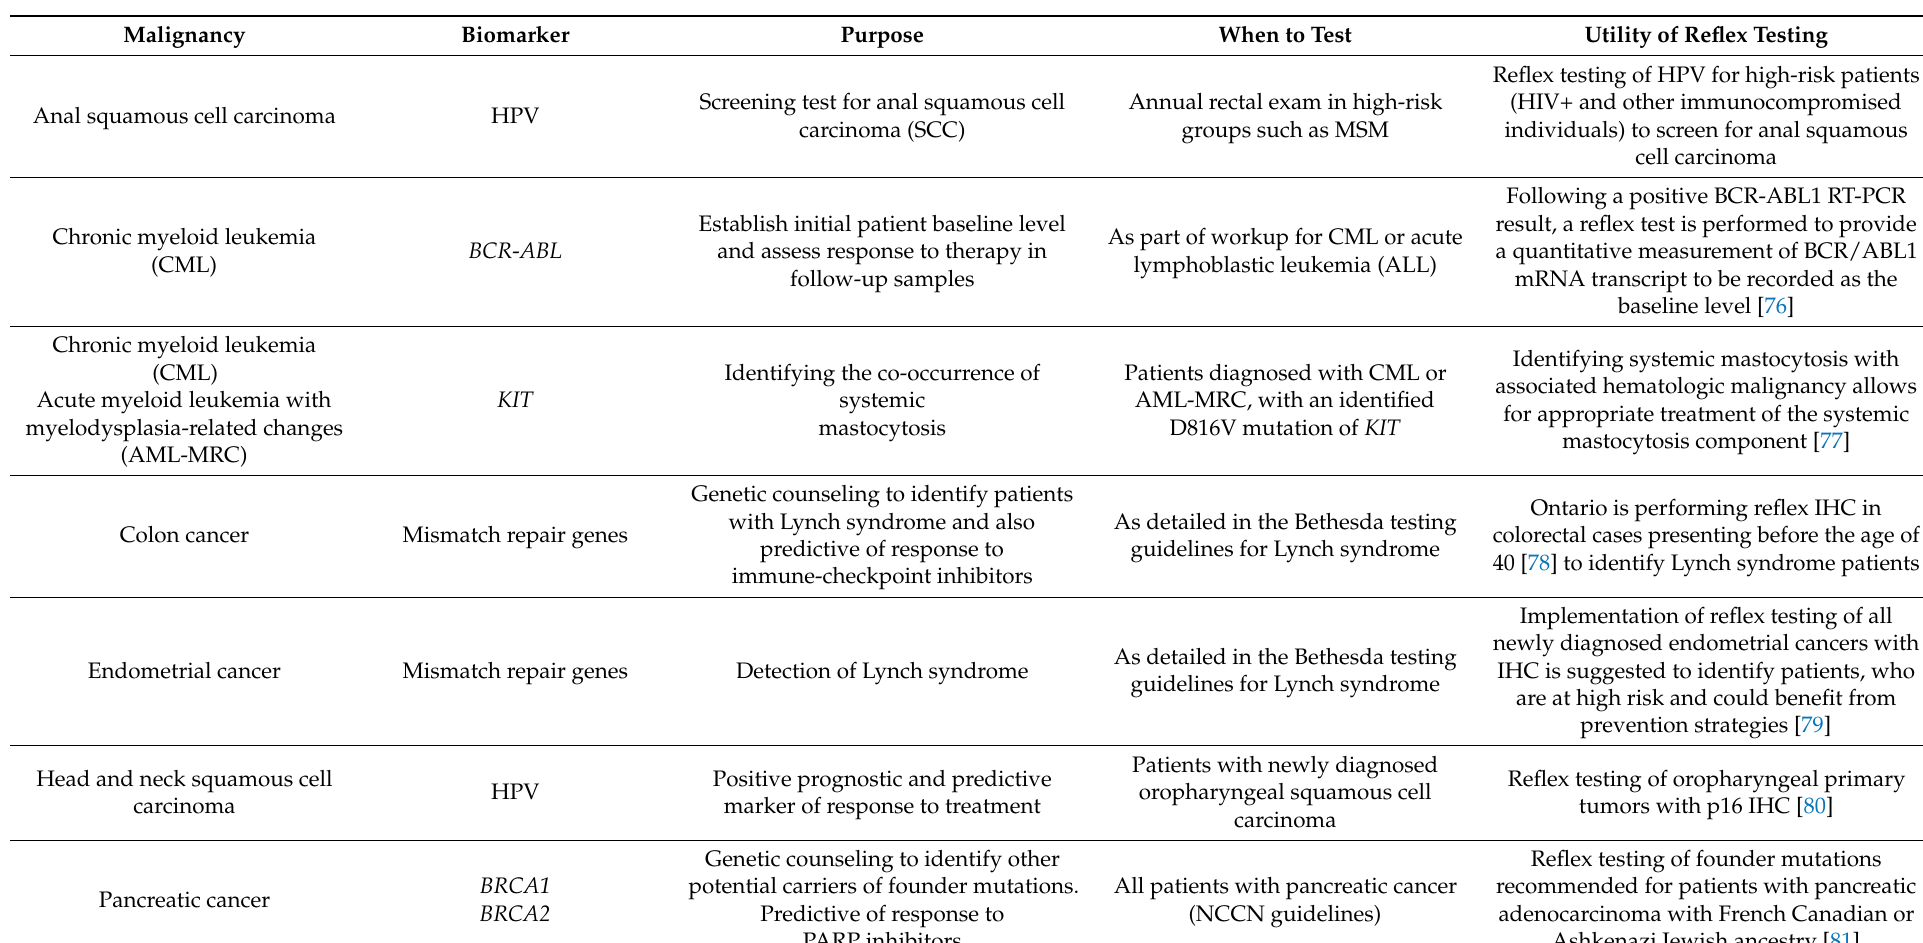
Table 4. Roles of predictive biomarkers in various types of cancer. Those presented below are examples of the utility of reflex testing for purposes primarily outside of direct